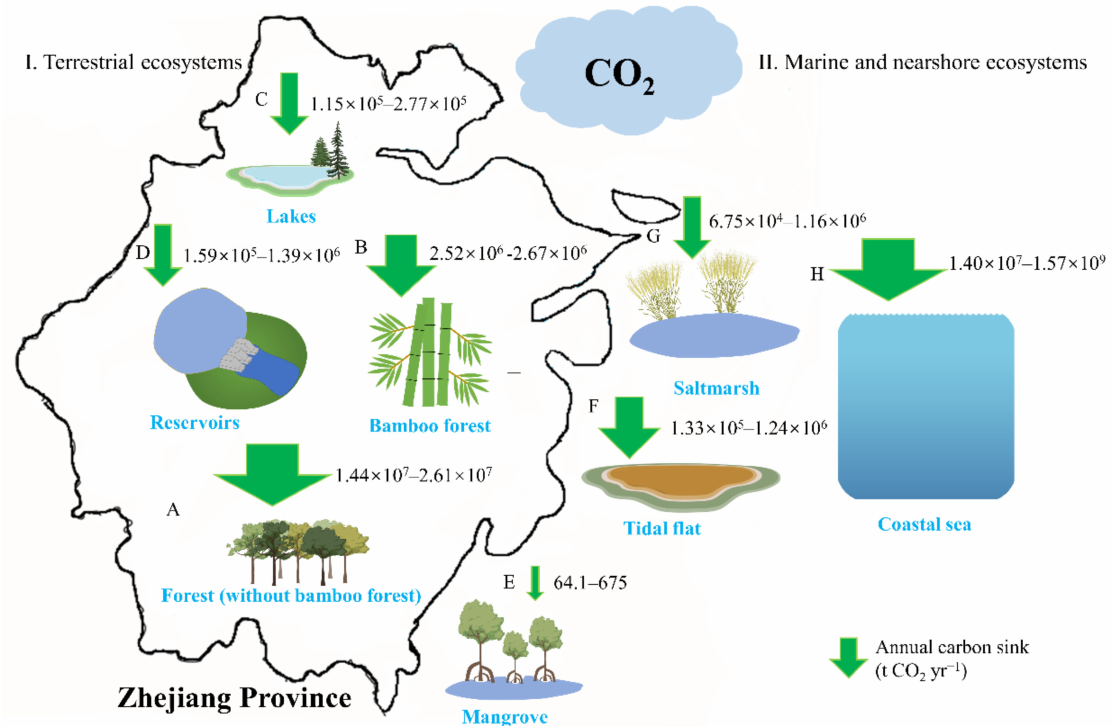
Figure 5. The current annual carbon sink status of the natural environment in Zhejiang Province. I. Terrestrial ecosystem. (A) Forests (without bamboo forest); (B) Bamboo forest; (C) Lakes; (D) Reservoirs; II. Marine and nearshore ecosystems (E) Mangrove; (F) Saltmarsh; (G) Tidal flat; (H) Coastal